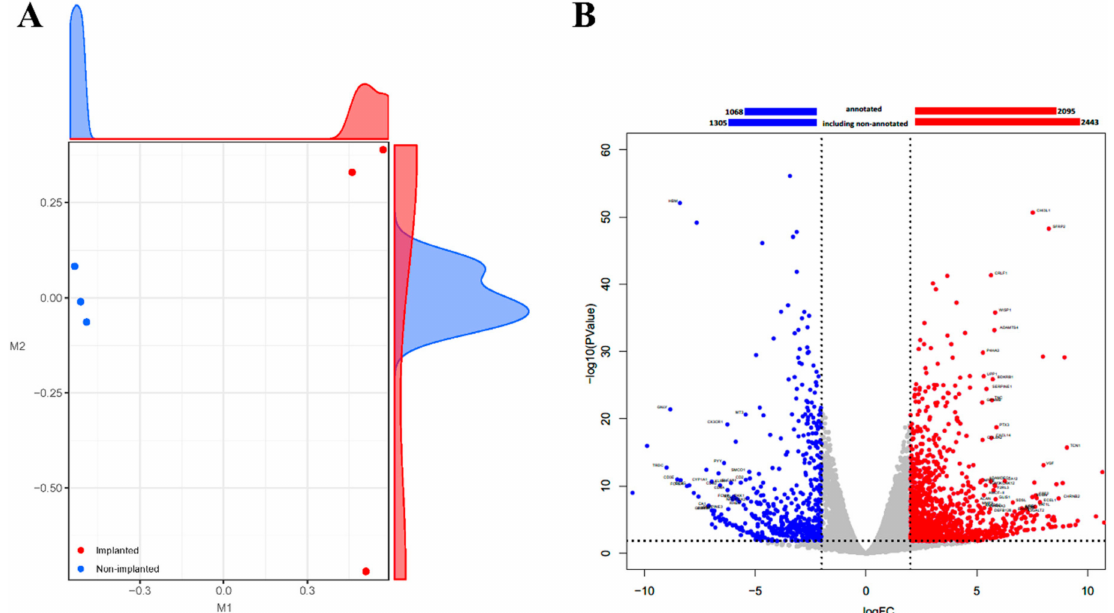
Figure 2. Overview of differentially expressed genes in the rejected porcine heart (XH-DEGs). ( A ) The multi-dimensional scaling plot of total RNAs NH (blue) and XH (red). ( B ) The volcano plot with a bar plot for differentially expressed genes (DEGs) of XH compared to that of NH. Individual colored dots indicate upregulated genes (red, FDR < 0.05 and logFC ≥ 2) and downregulated genes (blue, FDR < 0.05 and logFC ≤ − 2) in the treatment group. The labeled genes were the selected top 5% of the upregulated genes annotated by the gene symbol. The bar plot represents the number of DEGs for non-annotated and annotated